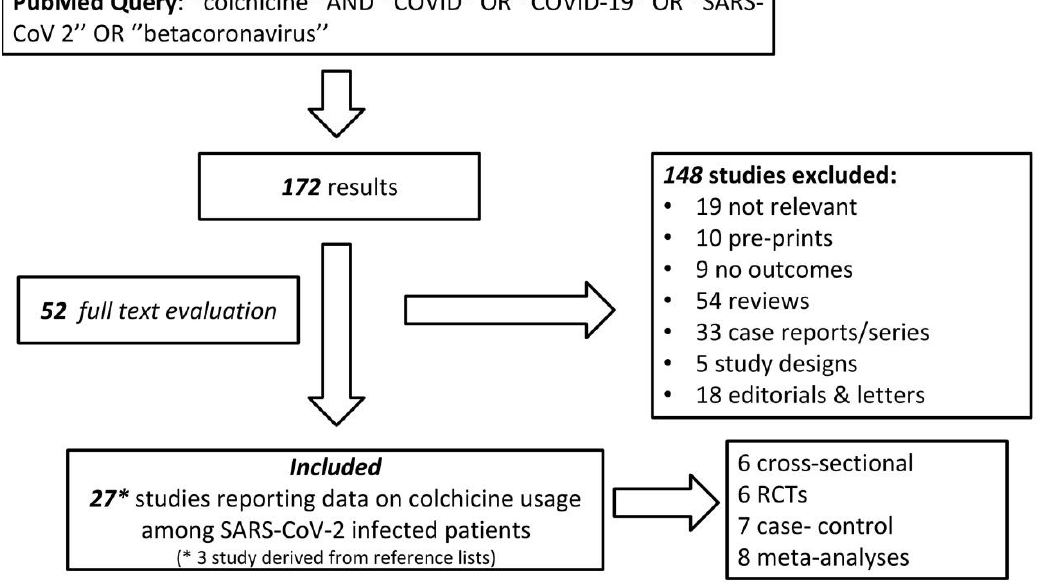
Figure 3. PubMed Query Flowchart.